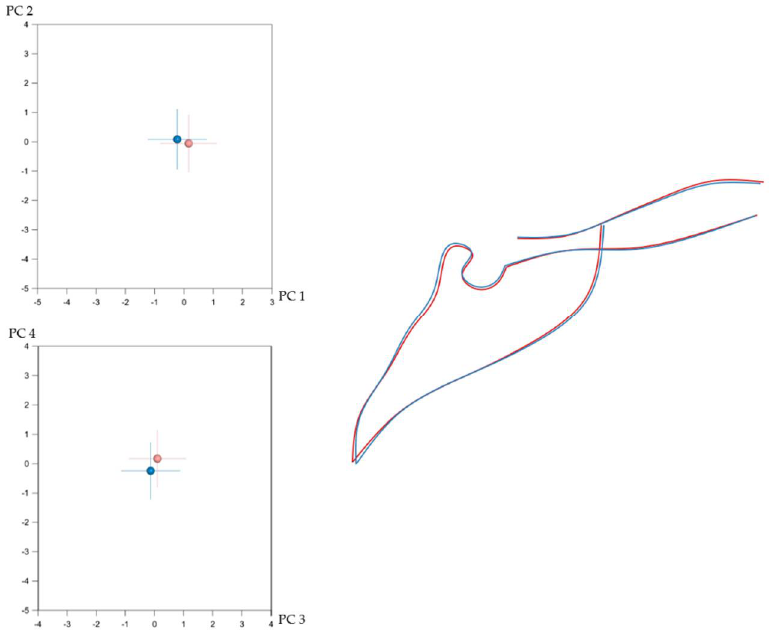
Figure 3. Left : Average difference between males (blue) and females (light red) in cranial base shape as explained by PC1 (17.4%)–PC2 (16%) ( top ) and PC3 (11.2%)–PC4 (9.8%) ( bottom ). The numbers in the parentheses represent the percentage of variation explained by each PC. Right : Best fit superimposition of average male (blue) and average female (light red) cranial base configurations.